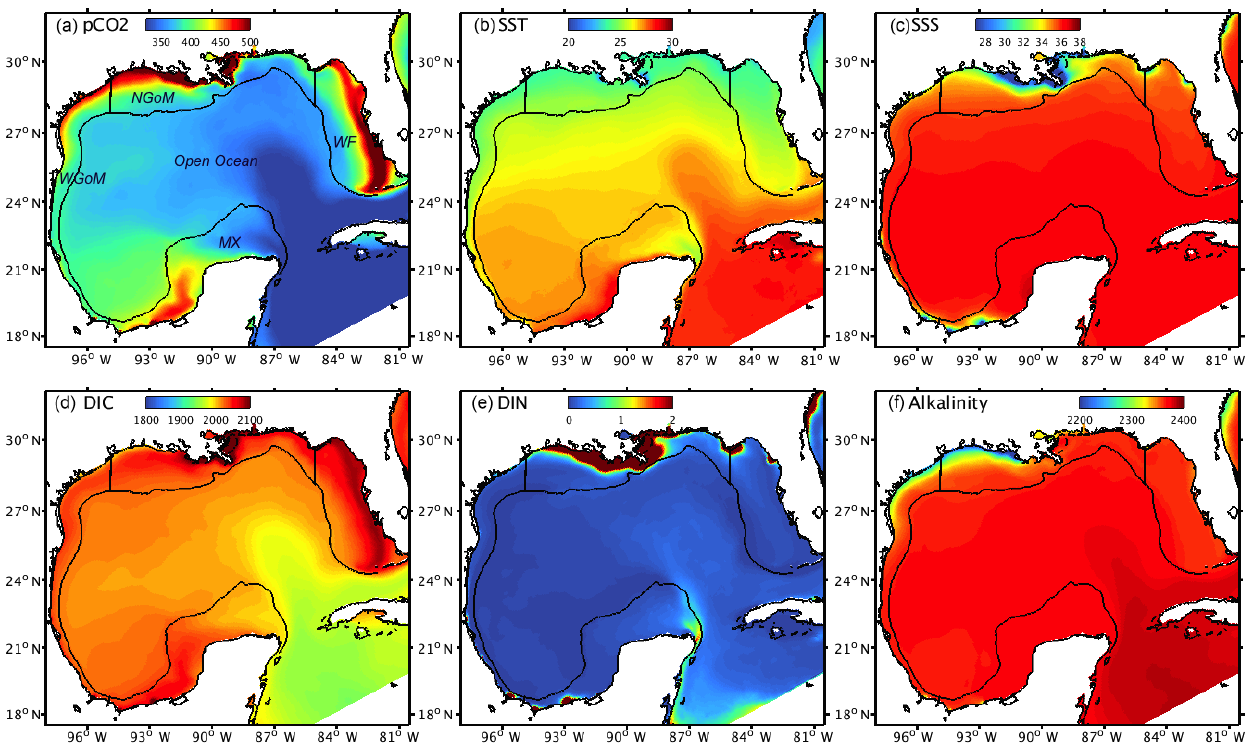
Figure 13. Six-year mean (2005–2010) surface conditions simulated by the model for (a) p CO 2 (ppm), (b) temperature ( ◦ C), (c) salinity, (d) dissolved inorganic carbon (mmolCm − 3 ) , (e) dissolved inorganic nitrogen (NO 3 + NH 4 ) (mmolNm − 3 ) , and (f) alkalinity (mEqm − 3 ) . Table 2. Spatial correlation coefficients between p CO 2 , sea surface temperature (SST), sea surface salinity (SSS), dissolved inorganic nitrate (DIN: NO 3 + NH 4 ) , dissolved inorganic carbon (DIC), alkalinity (ALK), and primary production (P-Prod) on the Louisiana Shelf and in the open ocean (multiyear mean of 2005–2010, control